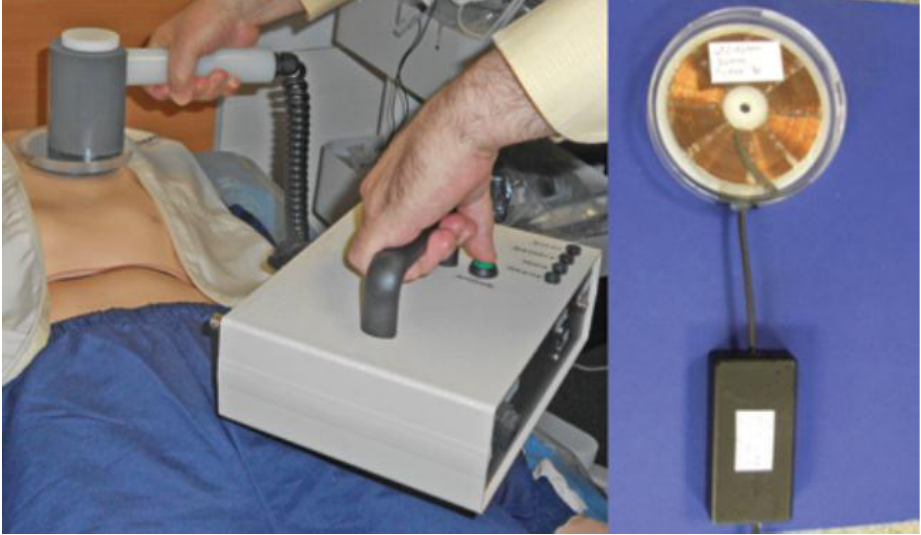
Figure 1. Top-level implantable transcutaneous RF power link architecture.